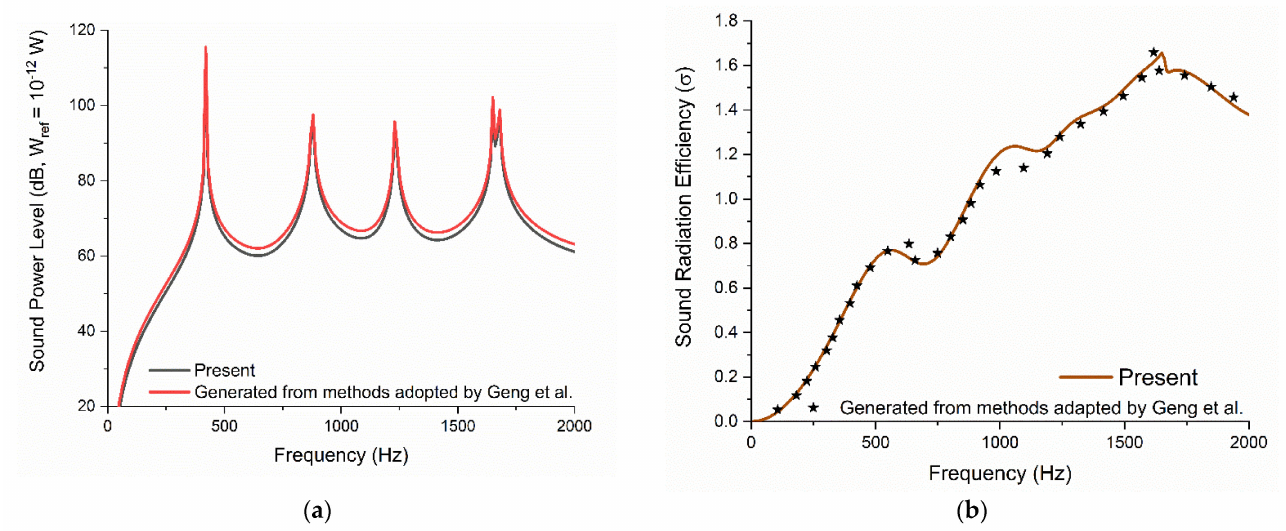
Figure 3. ( a ) Sound power level (SPL) and ( b ) radiation efficiency for k = 0 comparison with Geng et al. [7].